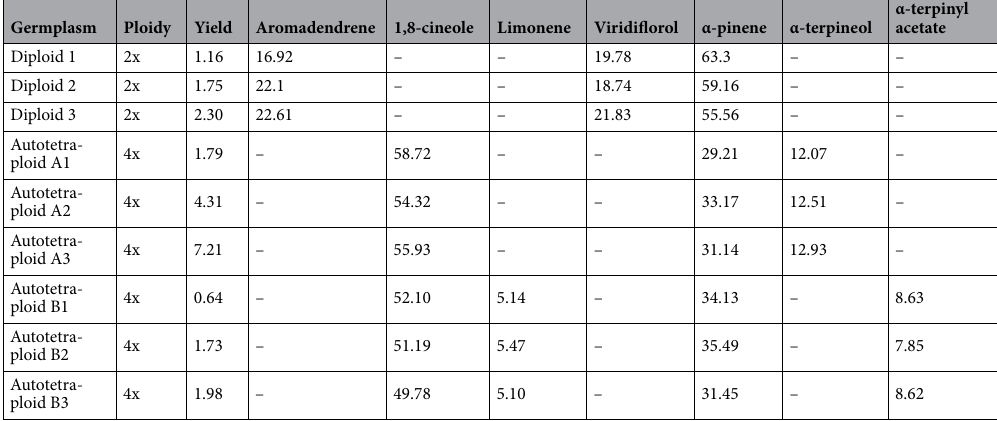
Table 1. Yield (%) and chemical composition (%) of the E. benthamii EOs. Diploid and Autototetraploids A and B germplasms were vegetative propagated. Identification 1, 2 and 3 refers to yield (lower, intermediate and higher, respectively).